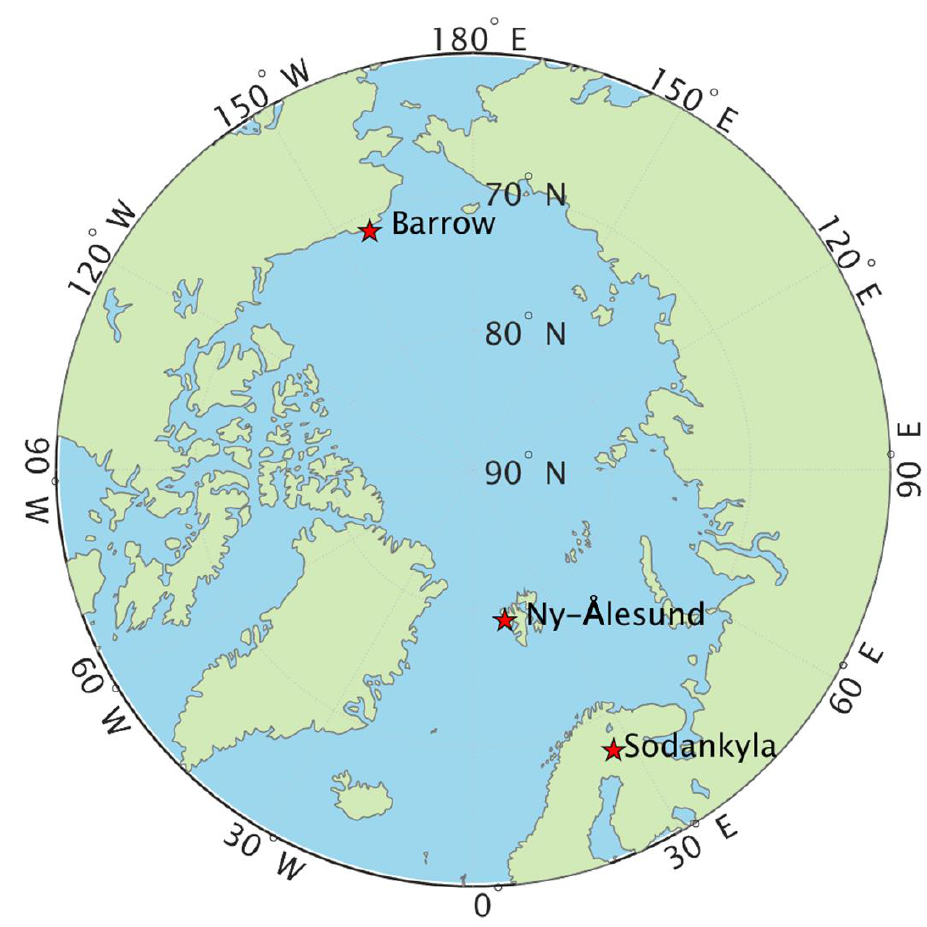
Figure 1. The GRUAN radiosonde stations in the Arctic. The red stars denote the locations of the sites.